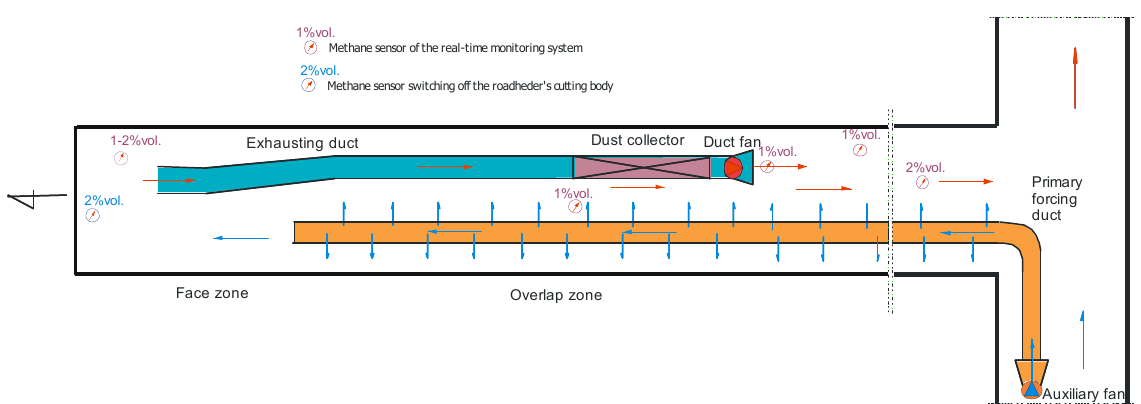
Figure 3. Scheme of the overlap auxiliary ventilation system with methane concentration measurement zones.